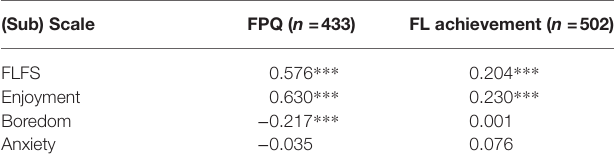
TABLE 4 | Correlation matrix of the Foreign Language Flow Scale and other